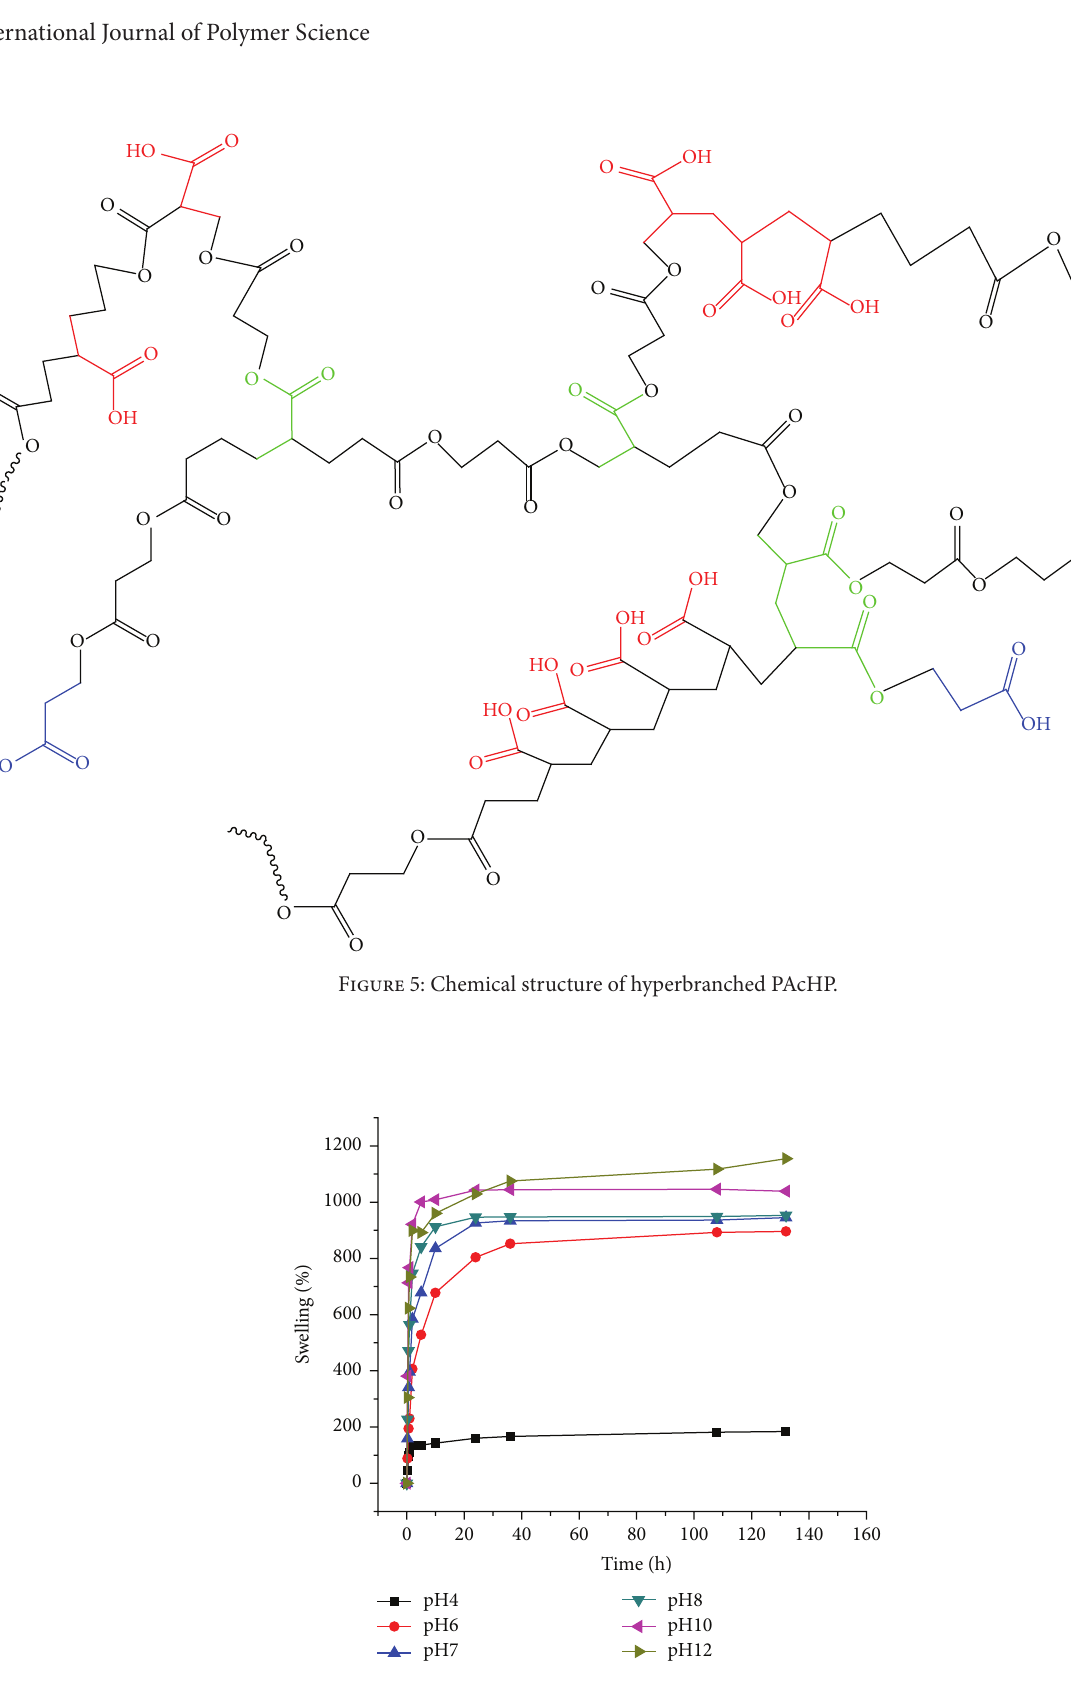
Figure 6: Time dependence of swelling ratio for hyperbranched PAcHP obtained from bulk polymerization at a wide range of